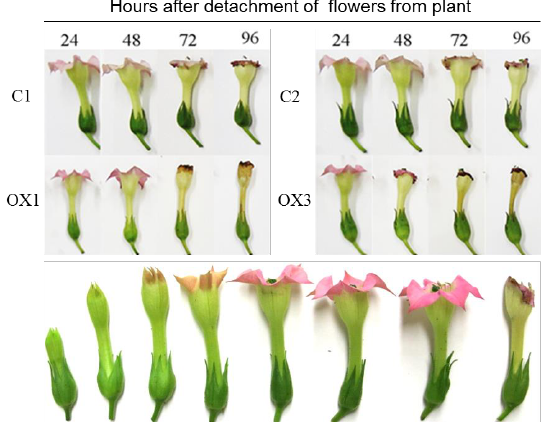
Figure 4. Effects of Sl -PI3K overexpression on senescence of detached Nicotiana tabacum flowers. Top panel: Detached flowers from control (C1 and C2) and transgenic tobacco lines with PI3K overexpression (OX1 and OX3) at stage 5 were stored at room temperature for 96 h in dark. Flowers were monitored and photographed every 24 h. C—Control, OX—PI3K Overexpressed. Bottom panel depicts the progressing developmental stages (1 to 8) of WT N. tabacum flowers.